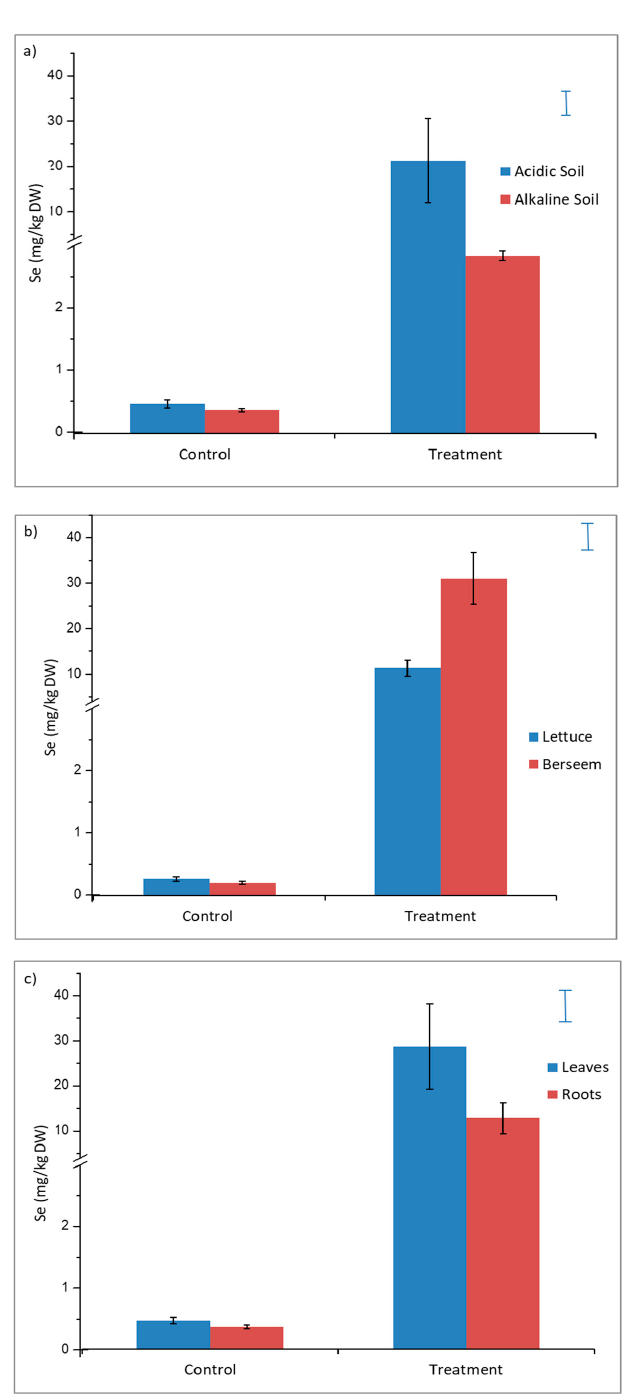
Figure 2. E ff ects of Se treatments (Control – Treatment Se); and ( a ) soil type; ( b ) cultivation; and ( c ) tissues independently of cultivation on plant Se content (mg / kg dry weight) In each column the bar on it represents the standard error of the mean. Bars at the right side of the graphs are the standard error of the ANOVA